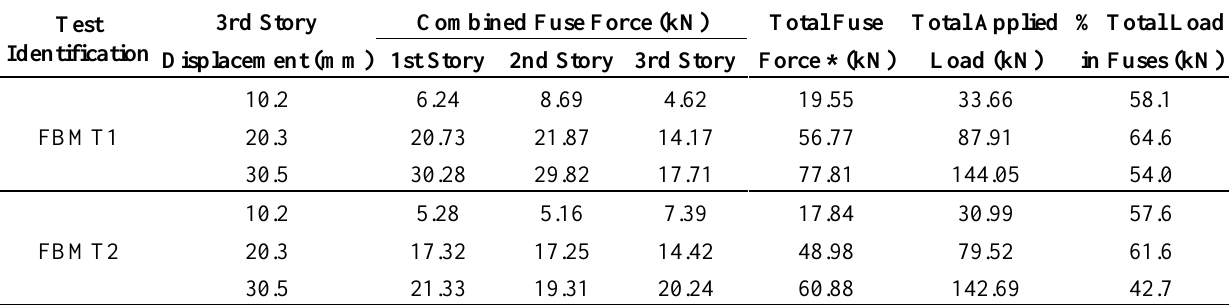
Table 6. Fuse forces transferred to infill panels during full brace monotonic tests.